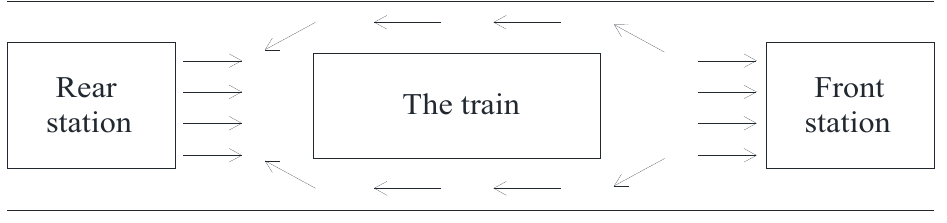
Figure 4. Formation mechanism of piston wind [79].